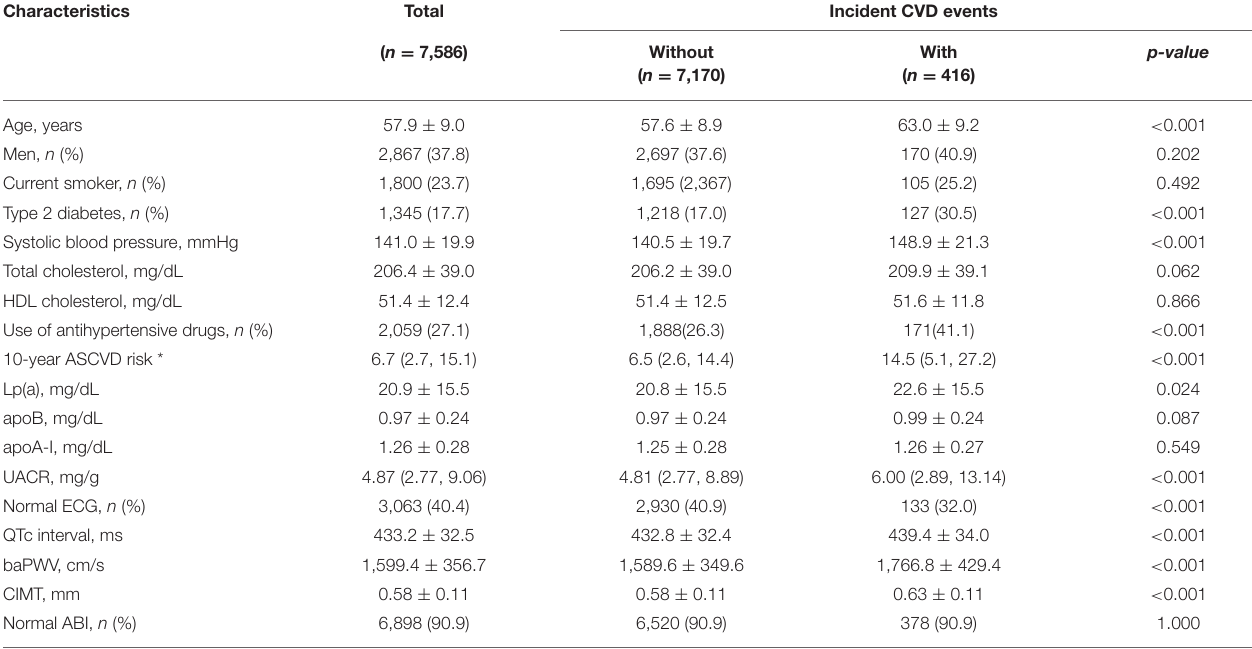
TABLE 1 | Characteristics of the study population at